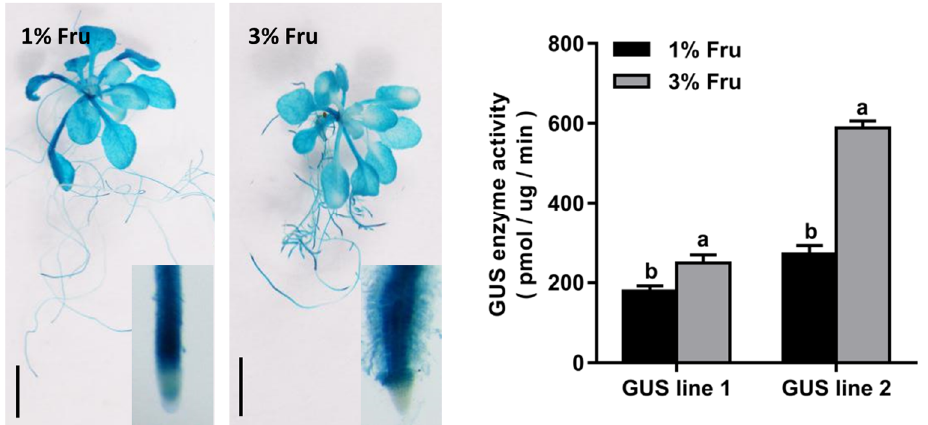
Figure 3. Induction of the CmTST1 -2K promoter in transgenic Arabidopsis in response to different sugars’ supply. Ten-day-old pCmTST1-GUS Arabidopsis transgenic plants (T2 generation) were transferred to different sugar conditions ( m/v ) for 7 days. The images on the left show the GUS staining, and the histograms on the right show GUS enzyme activity. Bars = 5 mm. The inserted pictures show the enlarged root. Results represent at least three biological replications. Lowercased letters (a or b) above the bar indicate that significant differences between different sugar treatments were assessed by using one-sided paired t -tests ( p < 0.05).